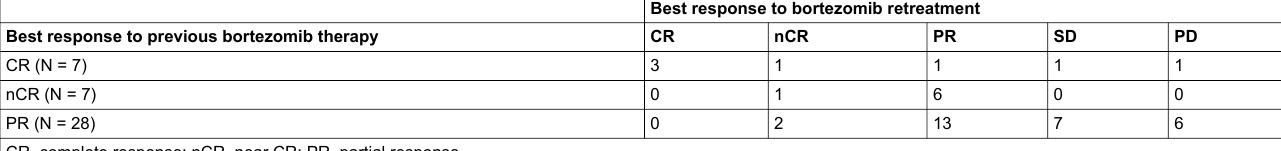
Best response to bortezomib retreatment